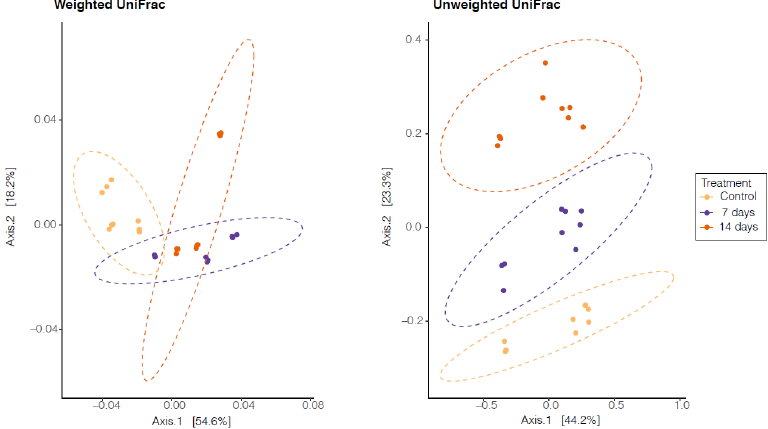
Figure 4. Principal Coordinate Analysis (PCoA) based on the abundance of operational taxonomic units (OTUs). Unweighted Unifrac p < 0.0002 and Weighted Unifrac p < 0.0001. Control = control period, 7 days: 7 days of treatment with L. helveticus R0052 and B. longum R0175 and 14 days: 14 days of treatment with L. helveticus R0052 and B. longum R0175. in the SHIME ® model showed that probiotics (7 and 14 days) significantly enhanced ( p <